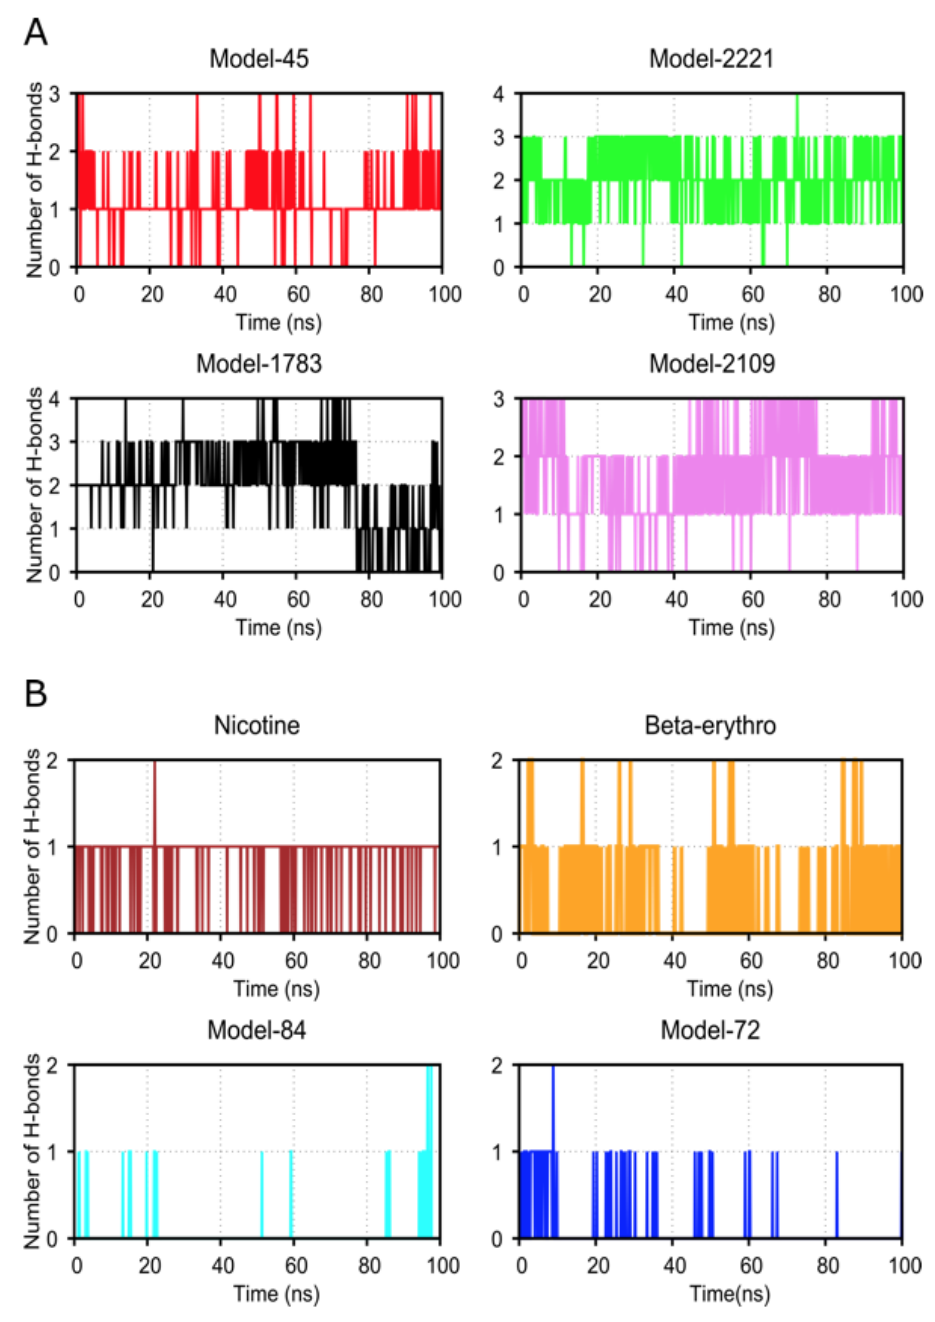
Figure 7. Graph of number of hydrogen bonds formed between receptor and analogs during simula- tions. ( A ) Number of hydrogen bonds between the four top-ranked compounds and the receptor. ( B ) Number of hydrogen bonds between the four lowest-ranked compounds and the